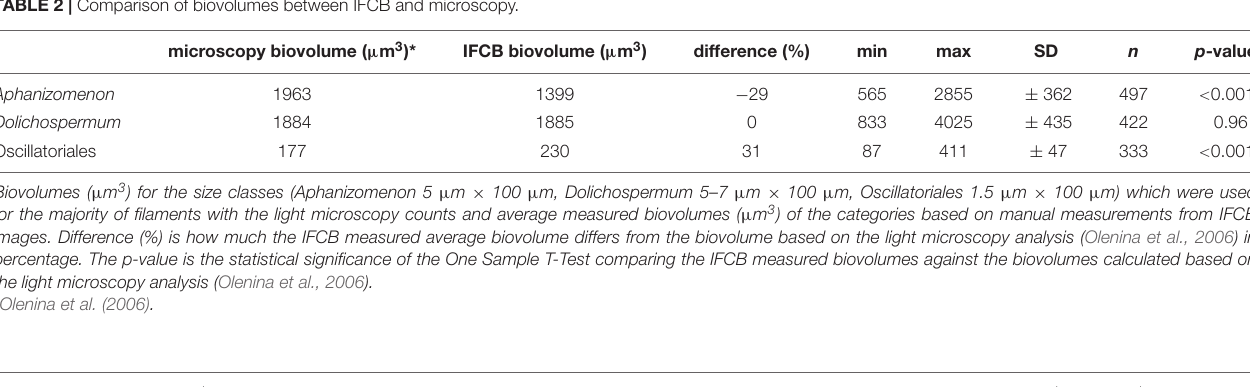
TABLE 2 | Comparison of biovolumes between IFCB and